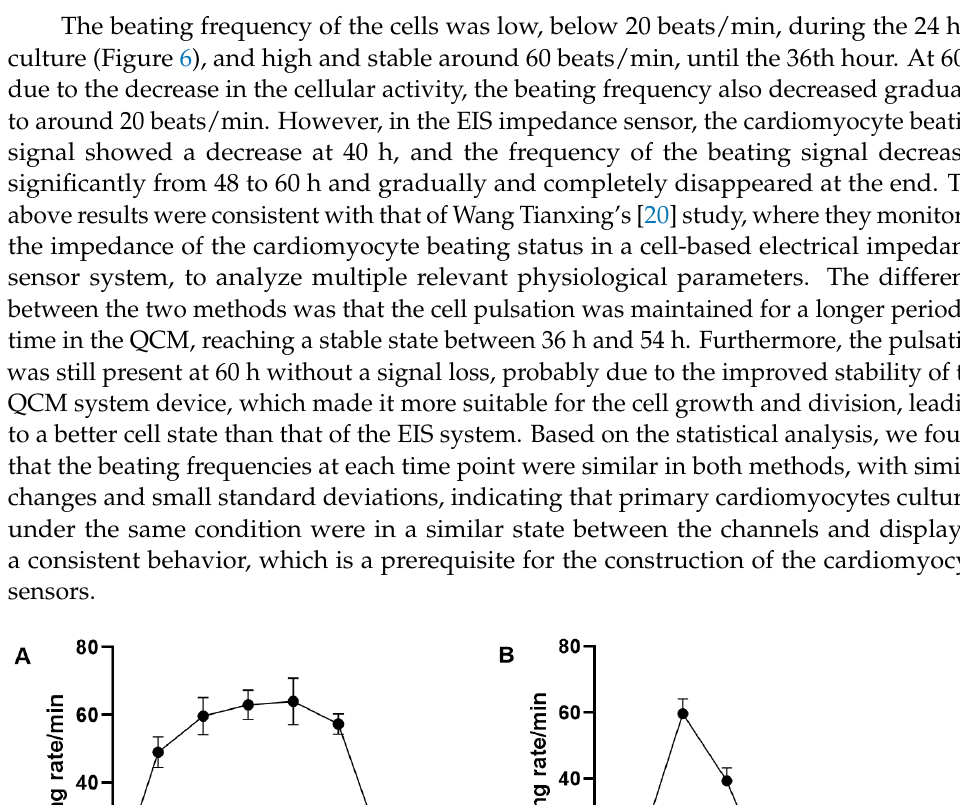
Figure 5. Cardiomyocyte beating signals detected by the QCM and EIS sensors at various time points. (The time duration of the signal fragment is 15 s, with a maximum frequency of 825 Hz in the QCM monitoring and a maximum CI of 0.6 in the EIS monitoring).